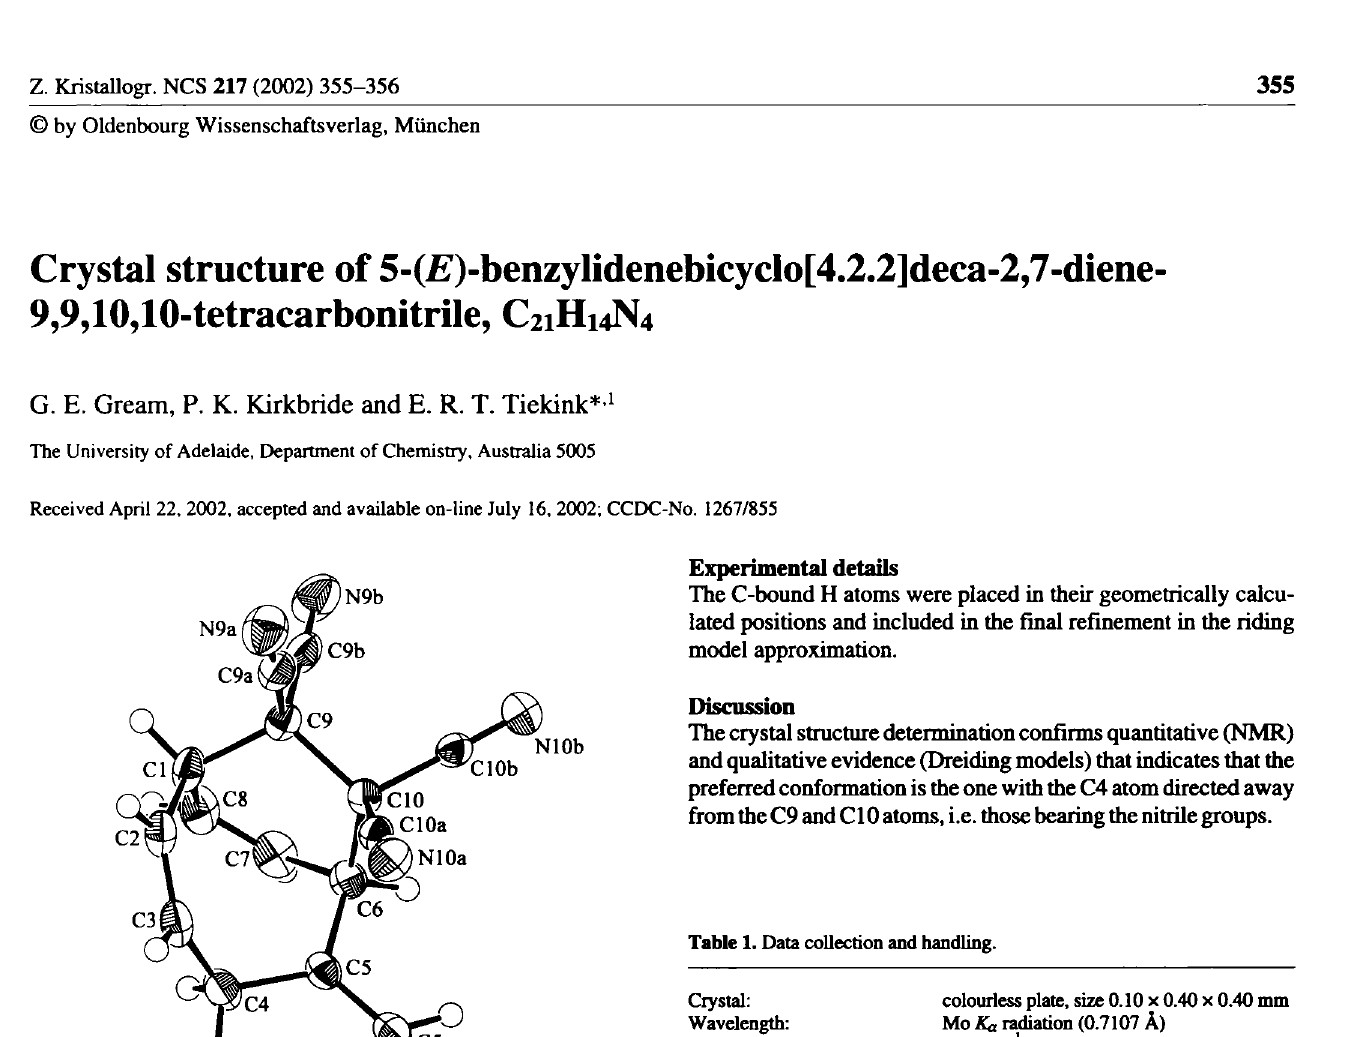
Table 1. Data collection and handling.